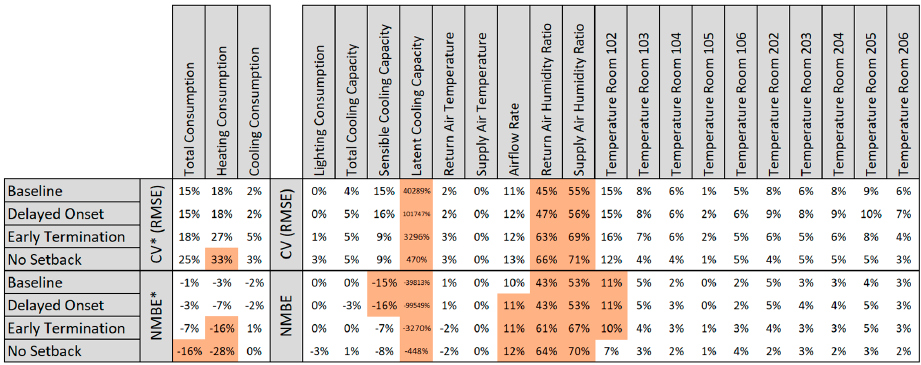
Table 5. CV (RMSE) and NMBE Calculations for Detailed Model Outputs: Lighting Setback Error.